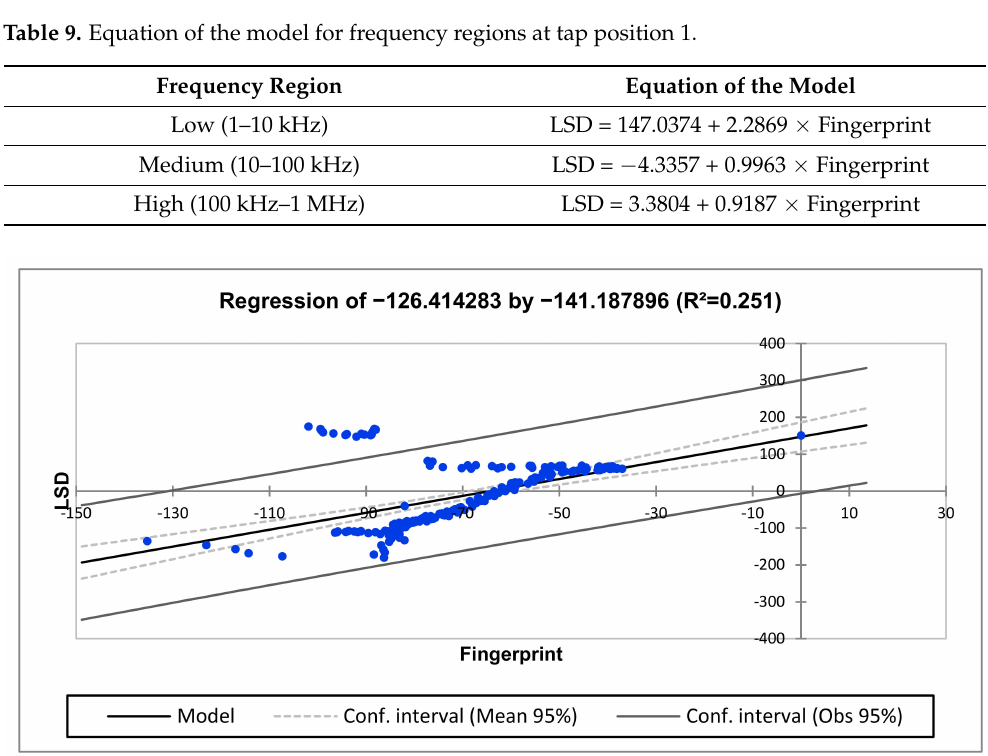
Figure 14. Regression of Phase C, tap position 1 (lower-frequency